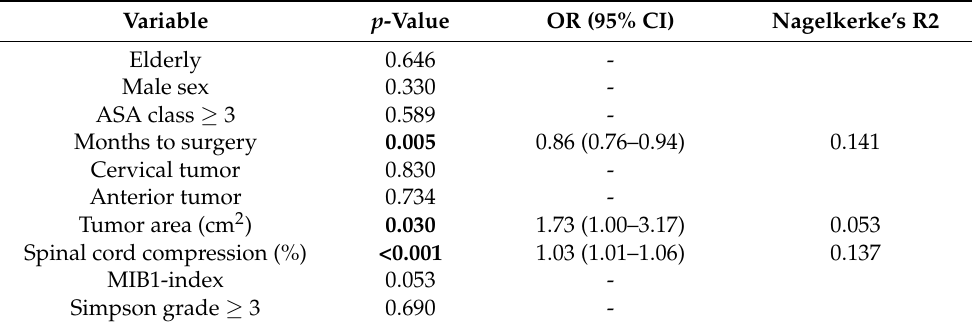
Table 6. Univariable logistic regression predicting postoperative improvement in mMCs.